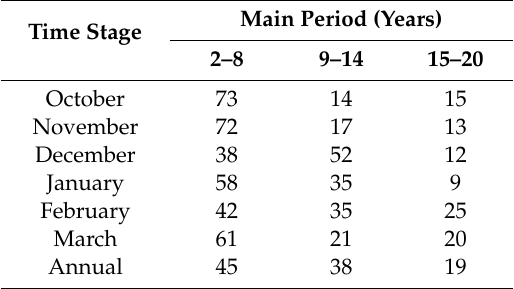
Figure 11. The periods spatial distribution of annual snow depth at 102 weather stations in Xinjiang over 1961–2015. Table 2. The number of sites that had di ff erent main-periods for the monthly and annual snow depths over 1961–2015 in